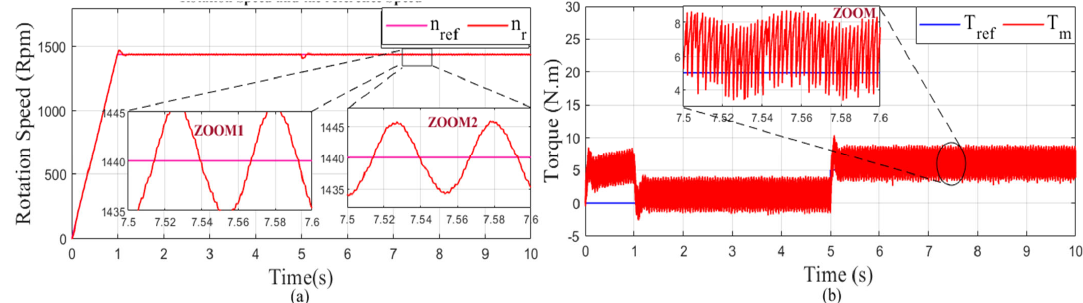
Figure 29. Performance with Ball bearing defect of IM with DTC control: ( a ) rotation speed and ( b ) motor torque.